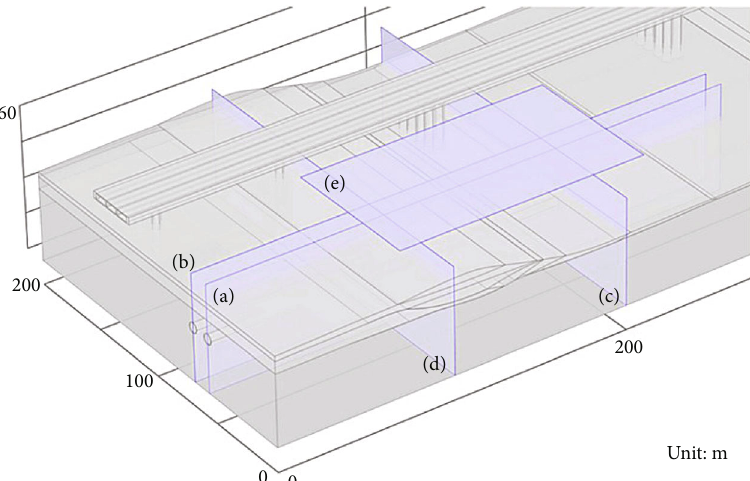
Figure 9: Sectional view orientation